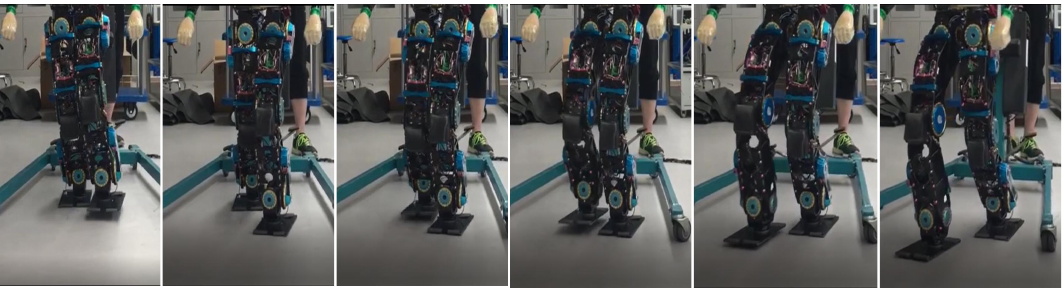
Figure 17. Experiments in the real humanoid robot.